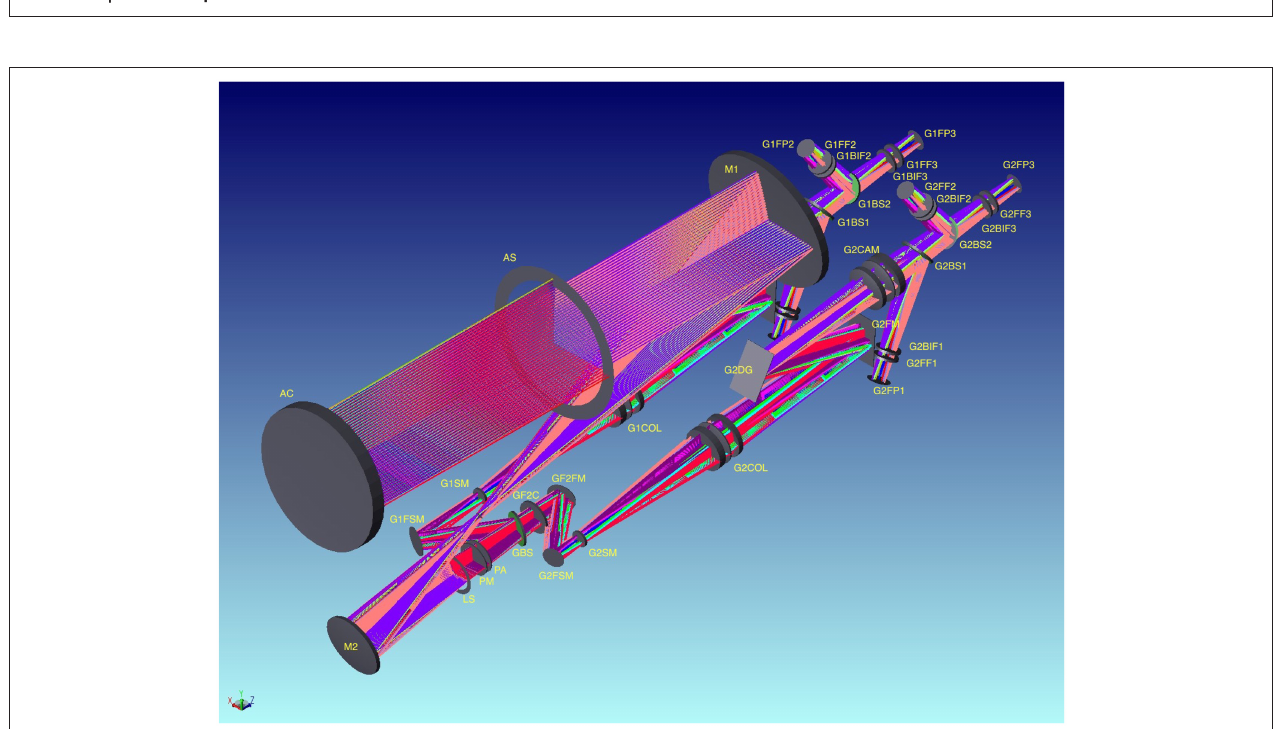
FIGURE 6 | ZEMAX Isometric view of